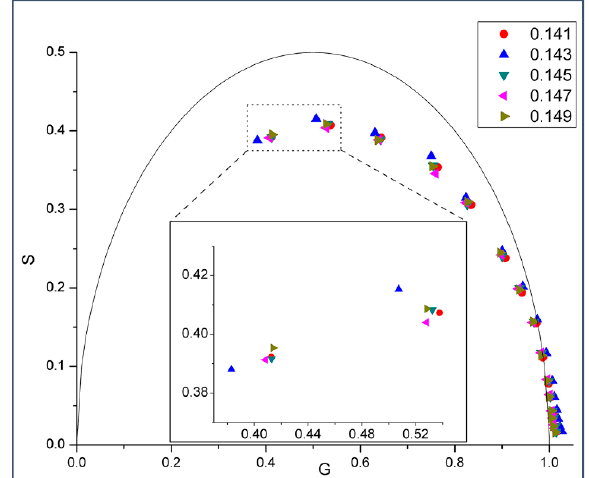
Figure 3. Phasor plot of gramicidin fluorescence lifetime in gramicidin A (gA)/DMPC MLVs. In this sample set, gA mole fraction was varied from 0.141 to 0.149 with an increment of 0.02. Samples were measured at 37 °C using 15 different modulation frequencies (from left to right) 200.00, 143.94, 103.59, 74.55, 53.65, 38.61, 27.79, 20.00, 14.39, 10.36, 7.46, 5.37, 3.86, 2.78, and 2.00 MHz. The semi-circular arc is called the “universal circle” [21]. Inlet: enlarged phasor data measured at 200.00 and 143.94 MHz; the relative errors of G (=M cos φ ) and S (=M sin φ ) are: G =0.00101–0.00102 (200 MHz) and 0.00146–0.00150 (143.9 MHz), and S = 0.00099–0.00101 (200 MHz) and 0.00101–0.00102 (143.9 MHz).